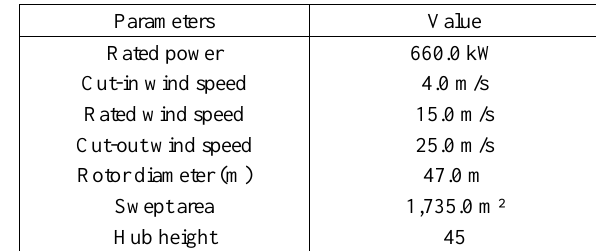
Table 6 . Technical characteristics of V47-660-45 wind